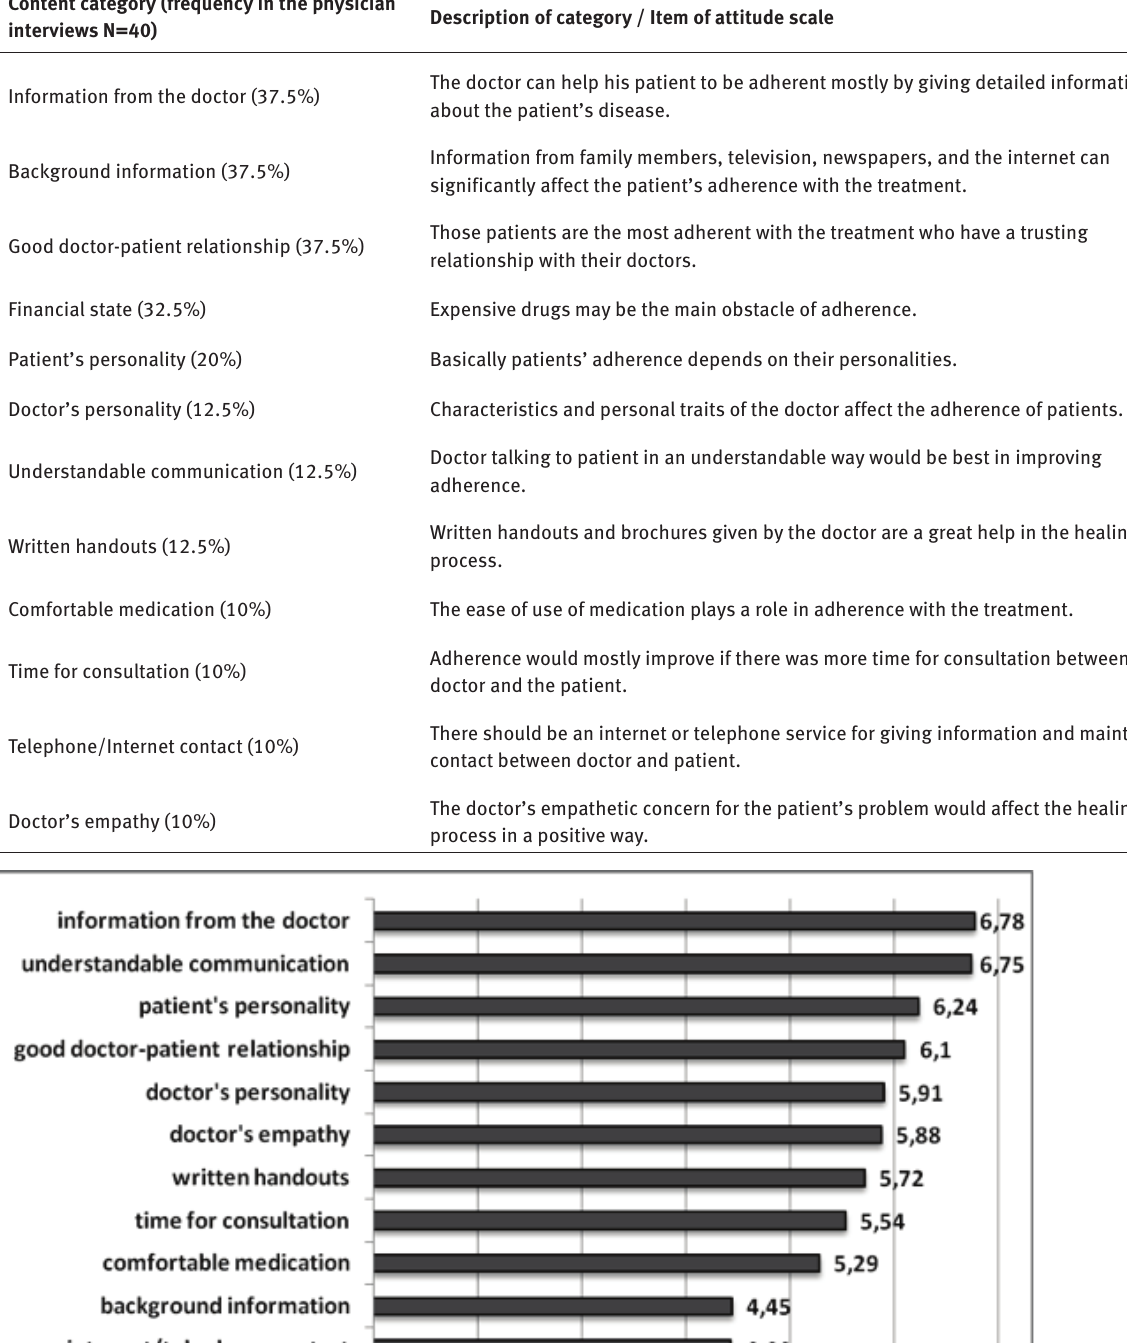
Table 1: Content categories and their frequencies in the interviews with the doctors (N=40), and items of the attitude scale which were created from the most typical statements under the content categories.